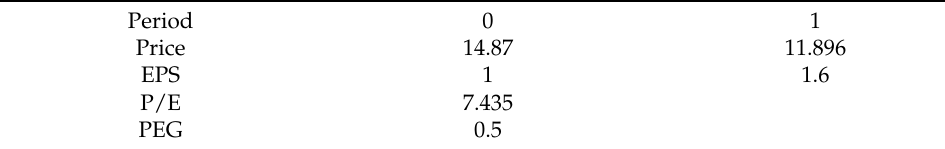
Table 5. The Effect of Negative Price